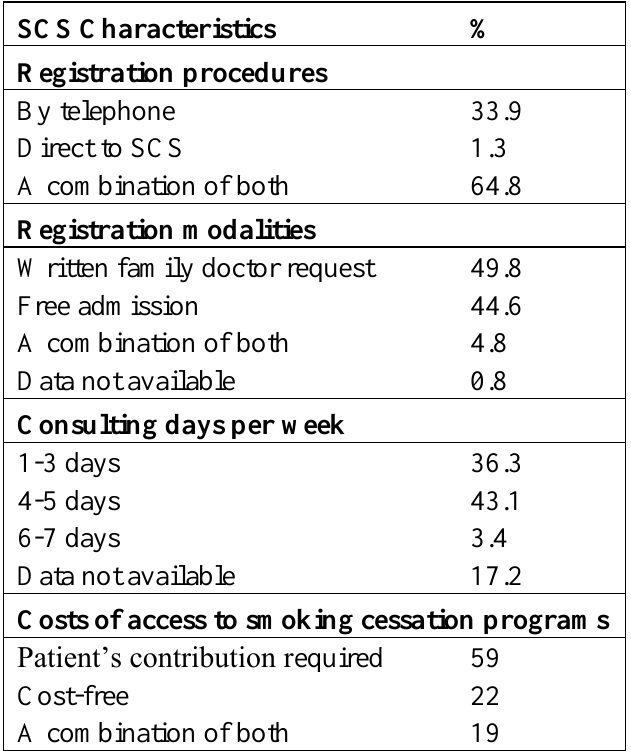
Table 2. Service Access